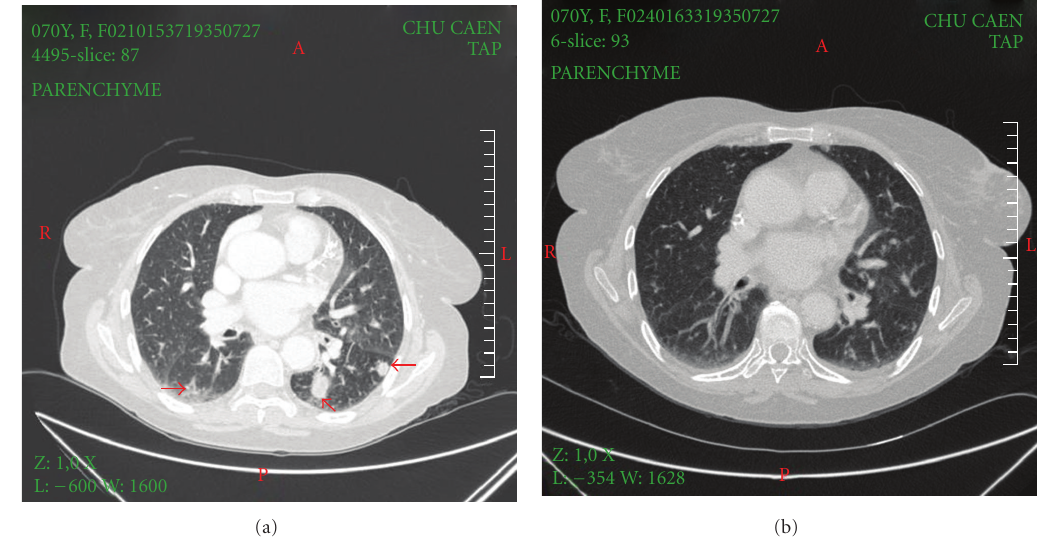
Figure 3: Pulmonary localisationof lymphomatoid granulomatosis.Transverse CT view, with contrast injection in parenchymatous window showingnodular lesionstakingcontrast. (a)At initialdiagnosis.(b) 2years after reduction in the immunosuppressionand rutiximab